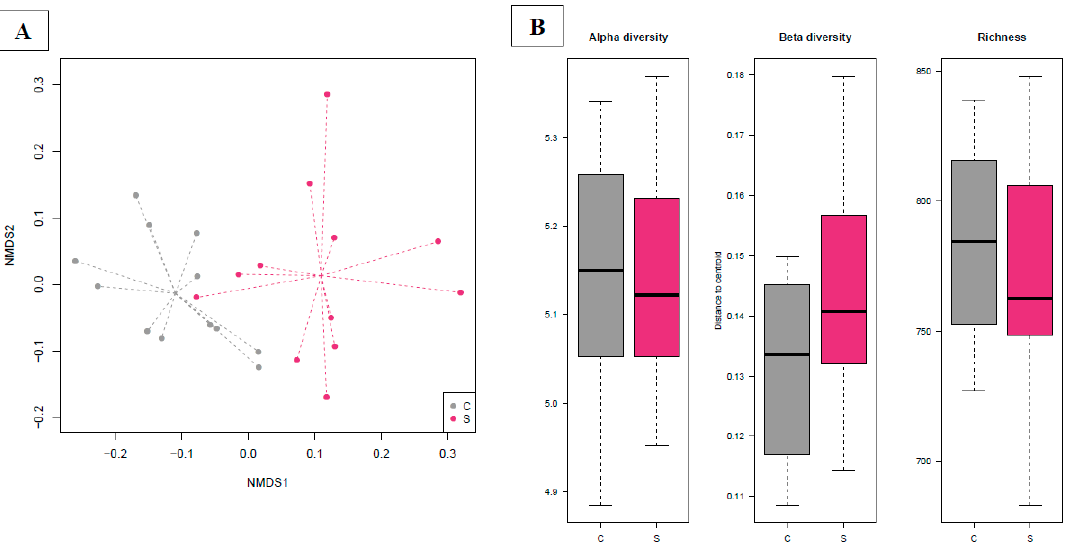
microbiota composition represented by the non-metric multidimensional scaling (NMDS) ordination